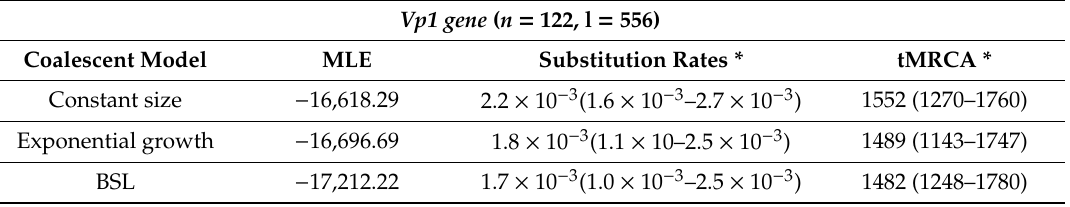
Table 1. Statistical parameters obtained under the relaxed lognormal molecular clock.